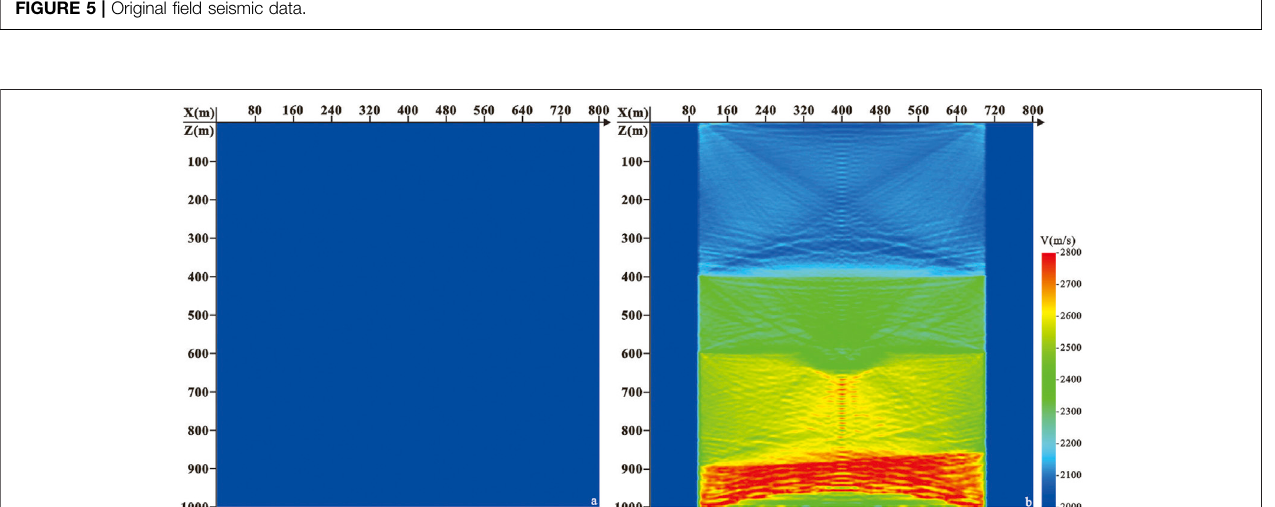
FIGURE 6 | Velocity model. (A) Initial velocity model and (B) velocity of fi rst-arrival wave tomography.